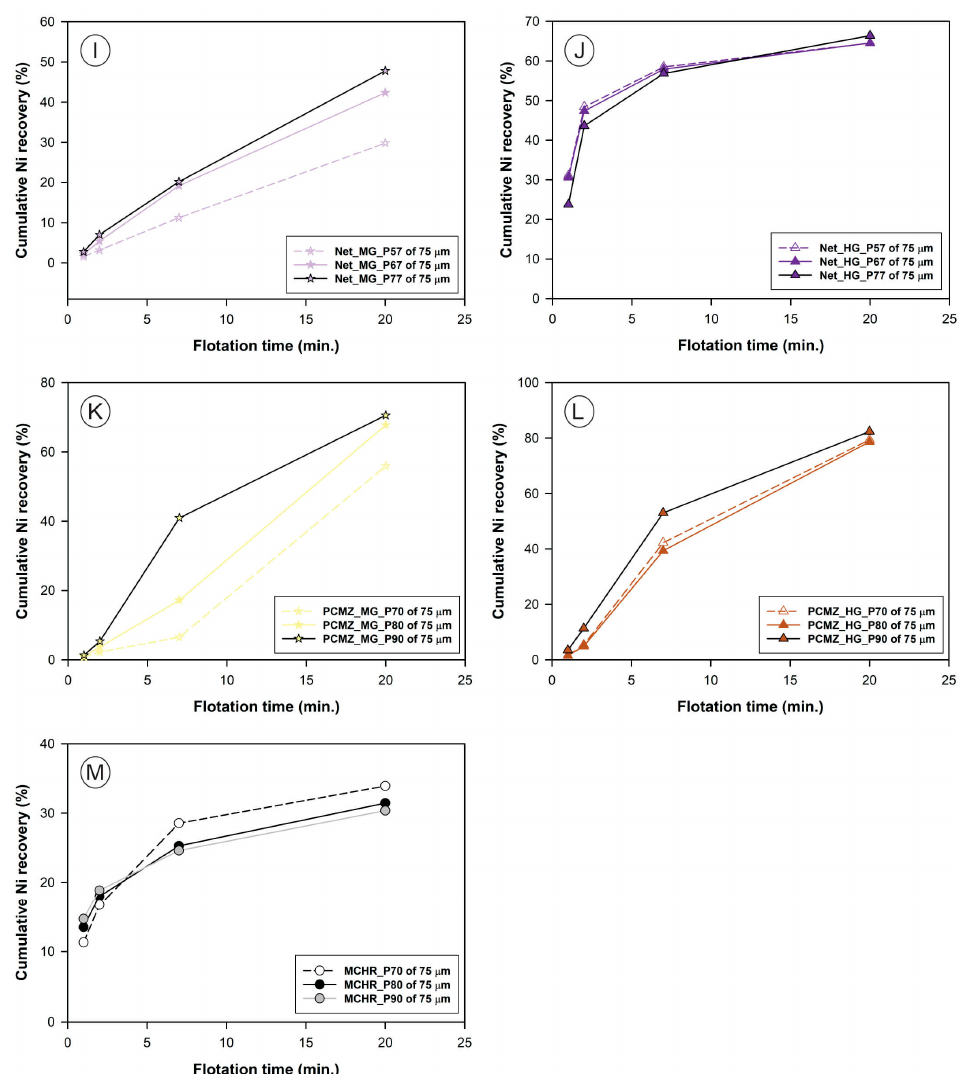
Figure 12. Cumulative Ni recovery as a function of flotation time for the flotation of the various ore types at the Nkomati Ni mine, milled to a grind of P57, P67, and P77 at 75 micron (( A – J ) MMZ ore horizon)) as well as a grind of P70, P80, and P90 of 75 micron (( K – M ) PCMZ ore